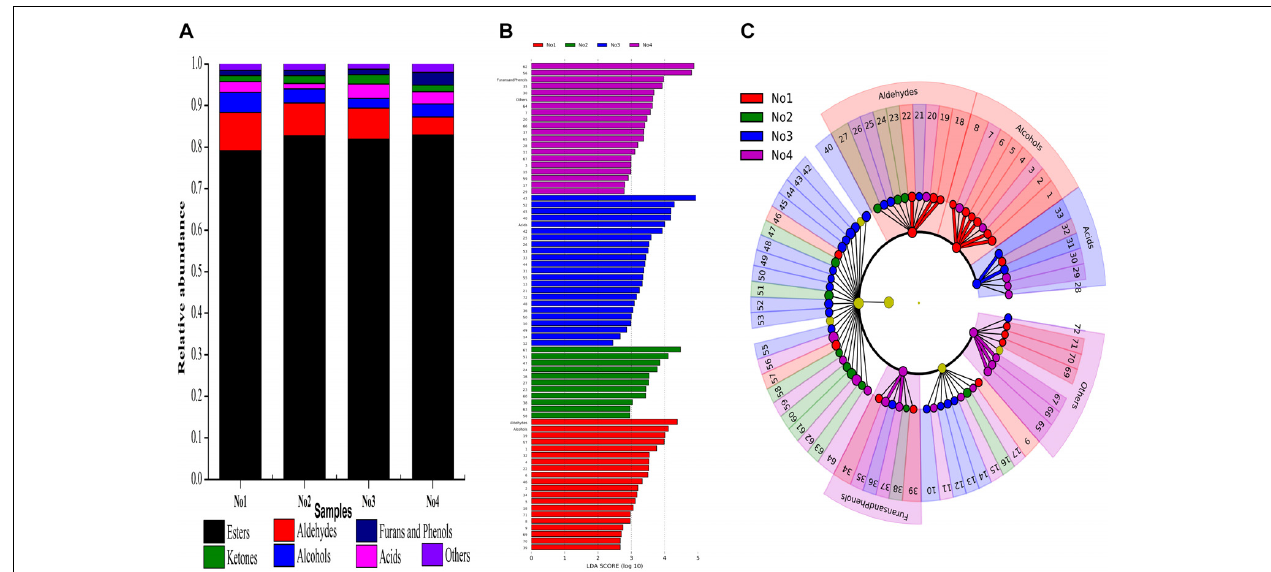
FIGURE 4 | (A) Proportions of volatile substances in the sample. Bar graph (B) , and Plot cladogram (C) results on the abundance of volatiles. Volatiles differentiality are represented by a linear discriminant analysis, coupled with effect size (LEfSe) (LDA > 2, P < 0.05). No1, No2, No3, No4 are represented by red, green, blue, purple, respectively. 1: hexanol 2: 2-heptenal 3: 3-methyl-1-pentanol 4: 1-octen-3-ol 5: 2,3-butanediol 6: benzenemethanol 7: benzeneethanol 8: trans- nerolidol 9: 3-octen-2-one 10: 3-nonen-2-one 11: 3,5-octadien-2-one 12: 6-dodecanone 13: 6,10-dimethyl-2-undecanone 14: cis- geranylacetone 15: